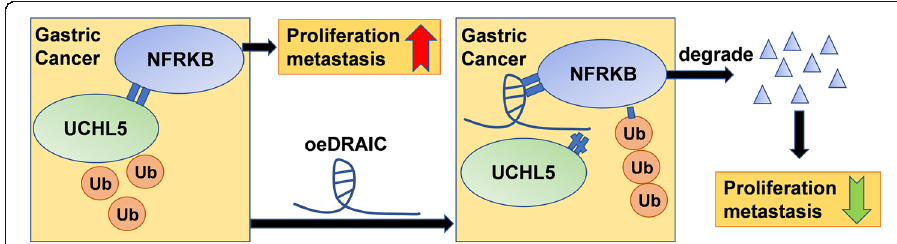
Fig. 7 Schematic diagram of lncRNA DRAIC/UCHL5/NFRKB in